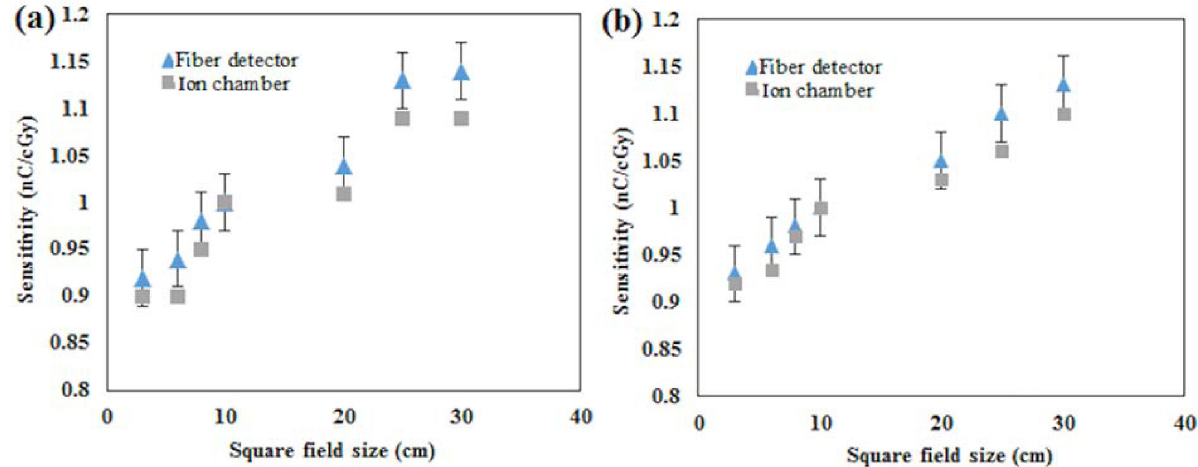
Fig 4. Sensitivity dependency of the PCF-collapsed on field size , the Sensitivity dependency of the PCF-collapsed on field size was measured for (a) 6MV and (b) for 10MV X-rays.